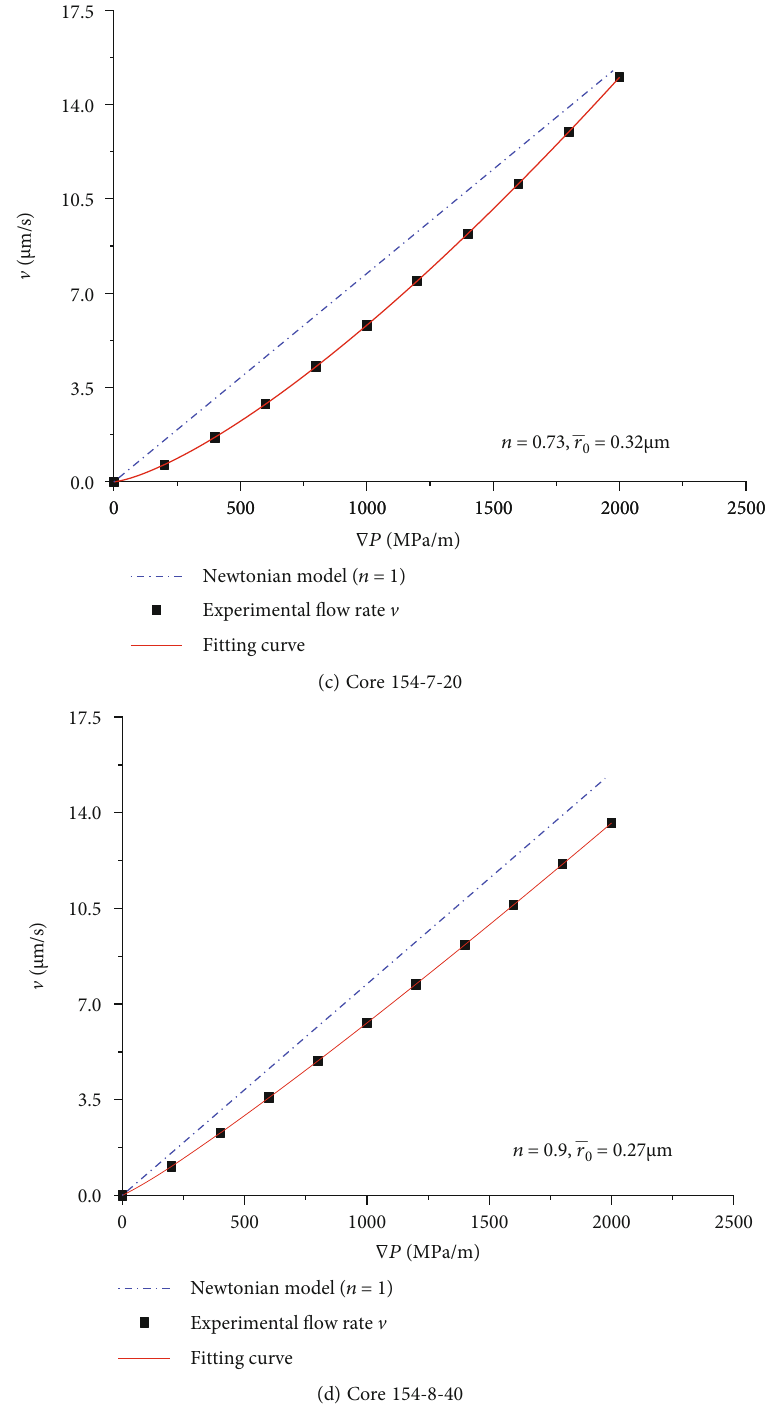
Figure 8: Nonlinear fi tting of pressure gradient and water velocity in